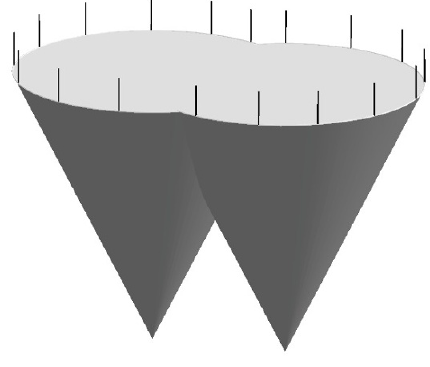
Figure 11 . The two cones can have a common edge as